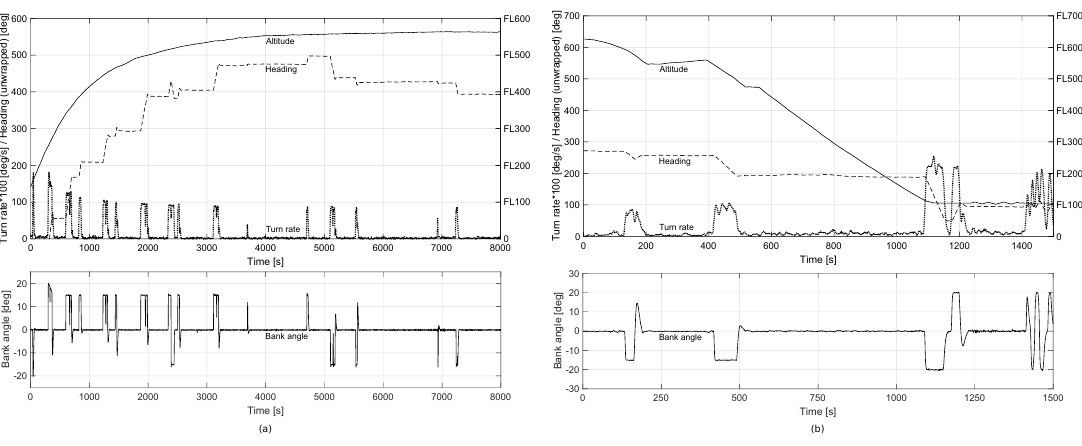
Figure 7. NS872 back angle overview along Mission 872-0060.